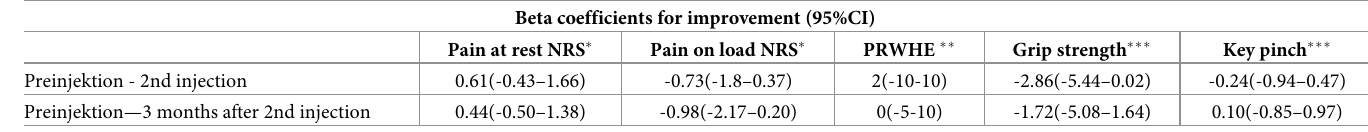
months after the first injection. There were no recorded infections or other adverse events.